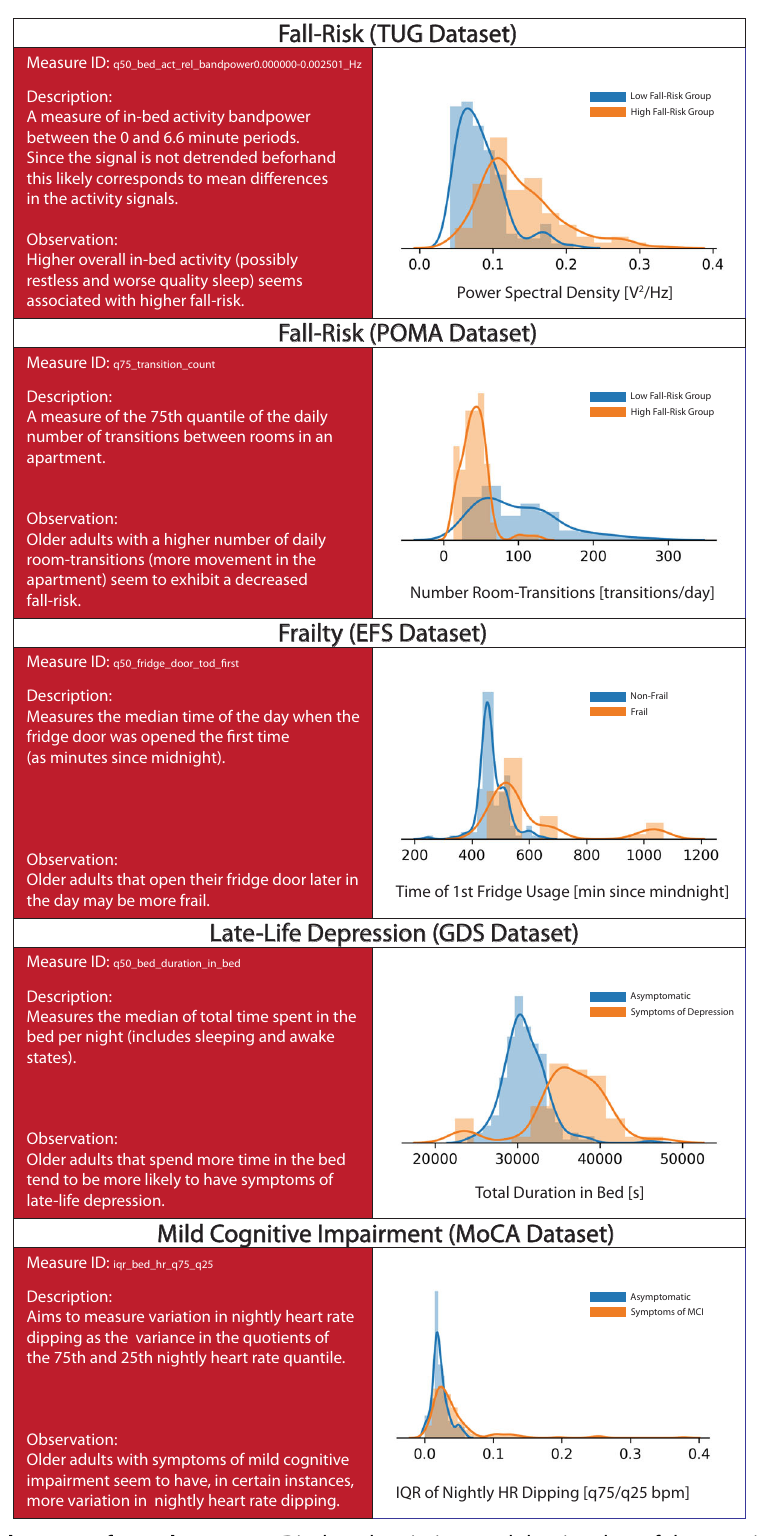
Fig. 2 Most important digital measure for each outcome. Displays descriptions and density plots of the most important digital measure for each outcome. Across all density plots, blue indicates a positive/neutral outcome, while orange indicates a negative outcome. It should be noted that the proposed associations re fl ect correlation and not causation and should be interpreted